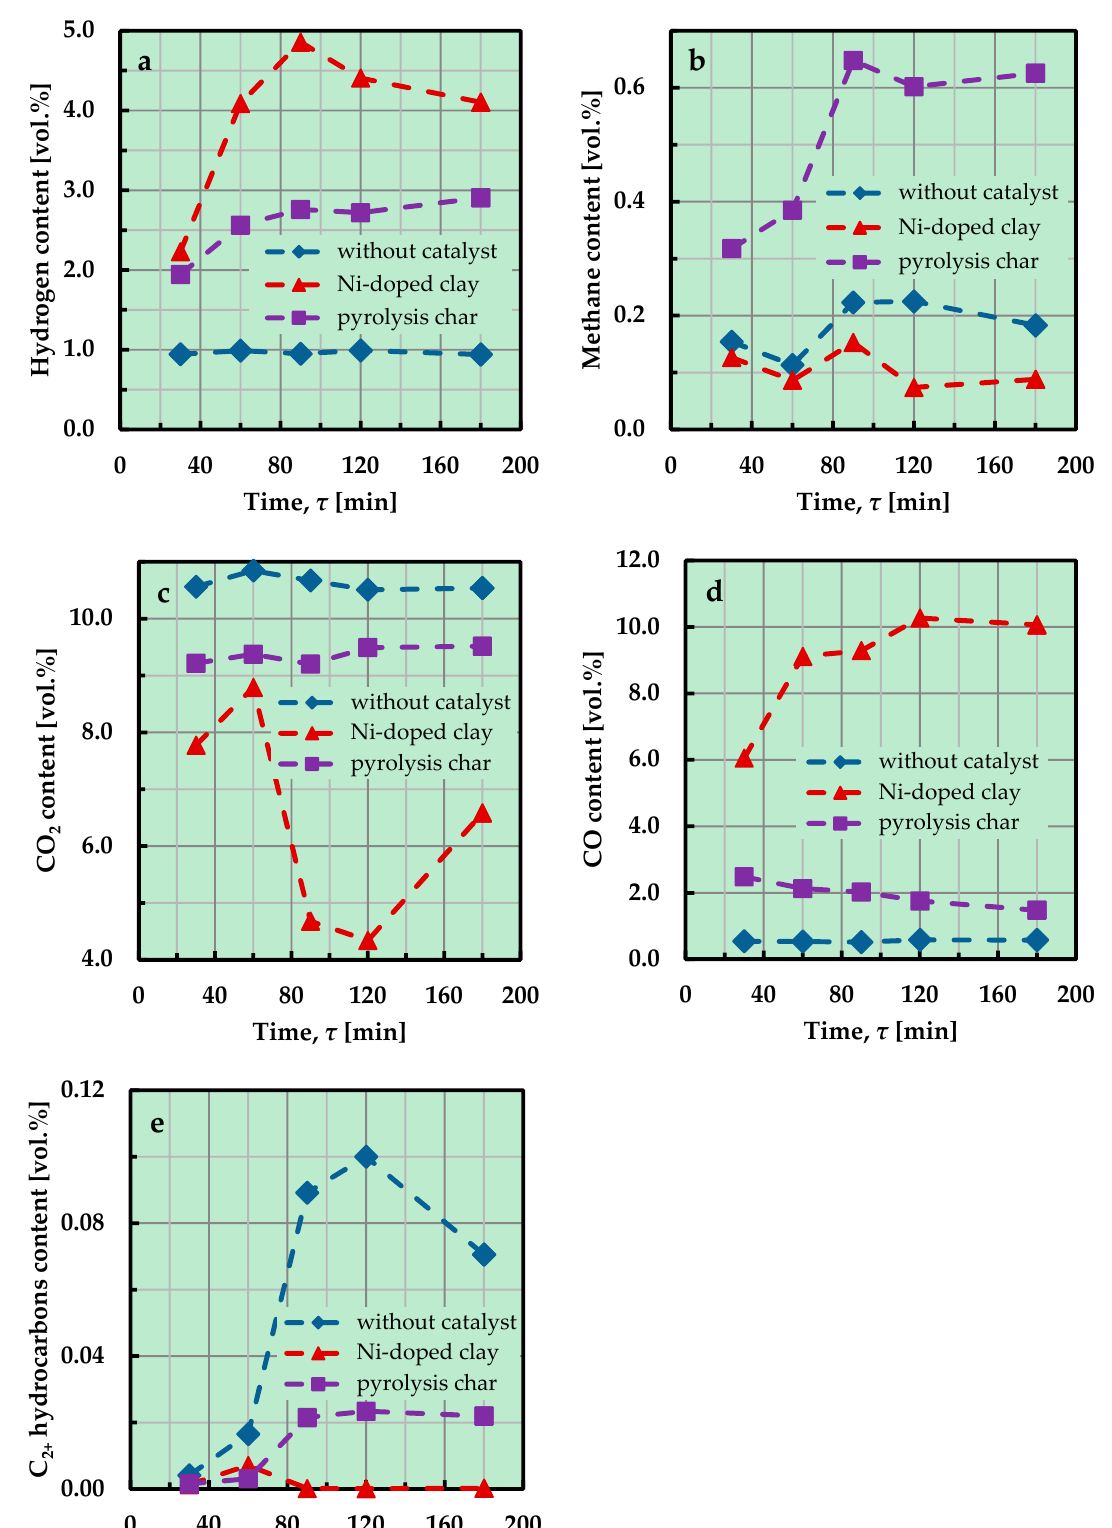
Figure 3. Variation of hydrogen ( a ), methane ( b ), carbon dioxide ( c ), carbon monoxide ( d ) and C 2+ hydrocarbons ( e ) content in process gas with reaction time for non-catalytic (diamonds), Ni-doped clay- (triangles) and pyrolysis char- (squares) catalyzed p -xylene decomposition. Results obtained using (0 g) 10 g of catalysts at 800 °C.